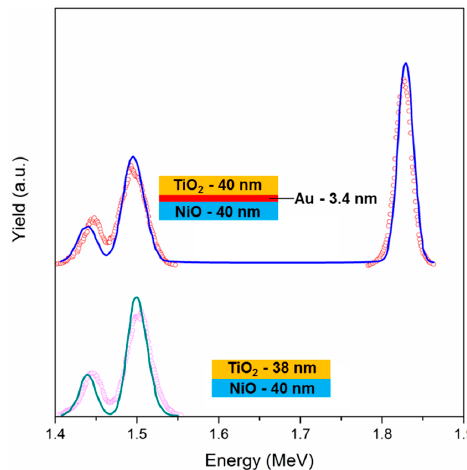
Figure 3. RBS spectra (open circles) and respective simulations (straight lines) of NiO-TiO 2 sample with and without an interlayer of Au NPs. The schematic representation of the layer stacks used for the fitting is also shown.